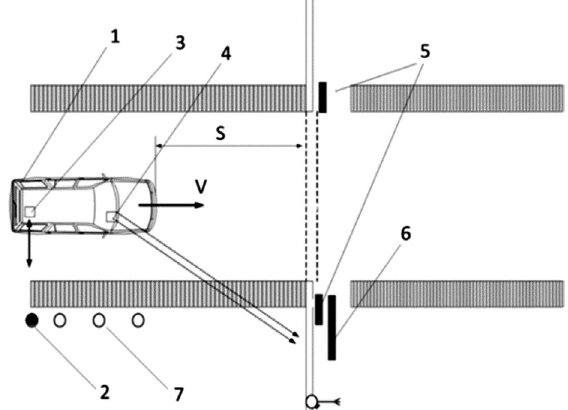
Fig. 7. Diagram of the measurement system on the